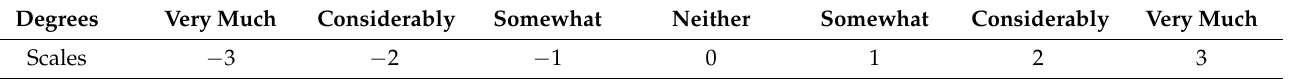
Table 3. Semantic differential rating